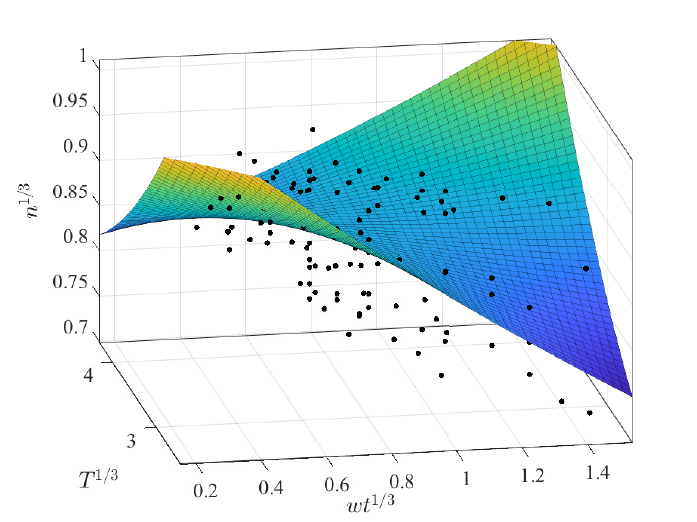
Figure 7. Best fitting results for the CMC dataset with n 1/3 as a function of wt 1/3 and T 1/3